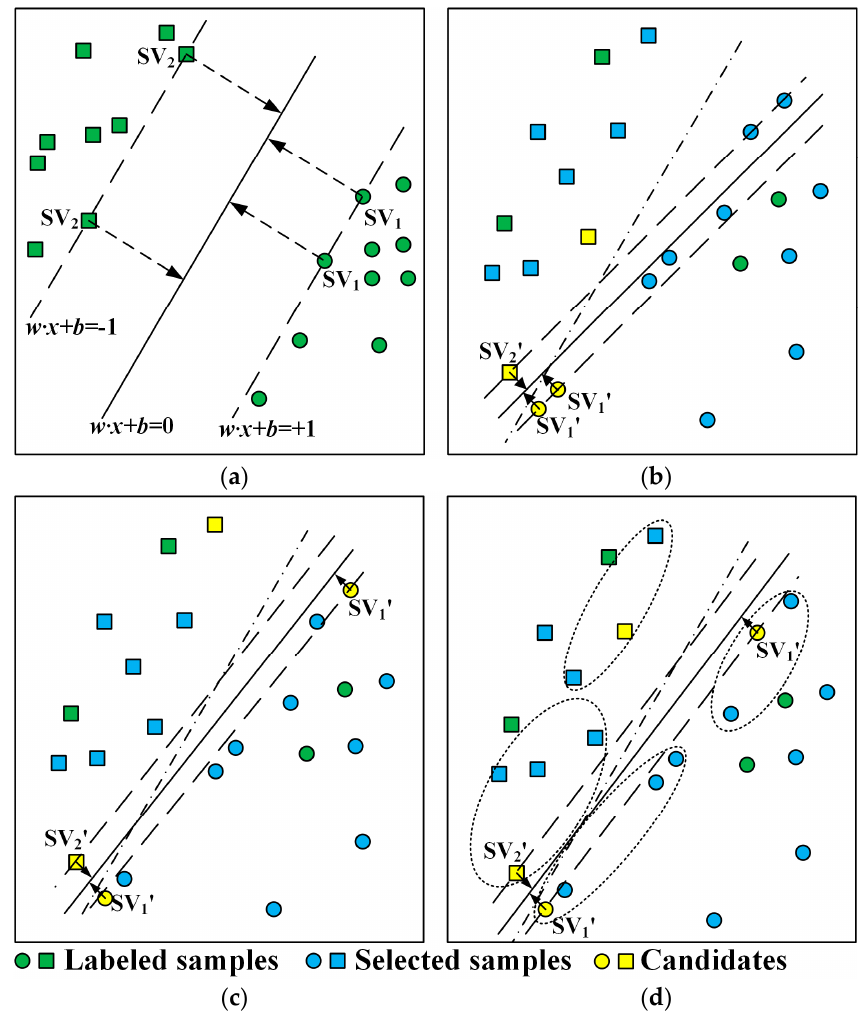
Figure 3. SVM hyperplanes and selected unknown samples. ( a ) The hyperplane obtained by the training set; ( b ) The retrained hyperplane after first iteration of AL. Four candidates have been selected; ( c , d ) The retrained hyperplane after first iteration using uncertainty rule and diversity rule. ( c ) Represents the similarity-based diversity rule, and ( d ) represents the cluster-based diversity rule. (The dot-dash lines in ( b – d ) denote the hyperplane in ( a ).)